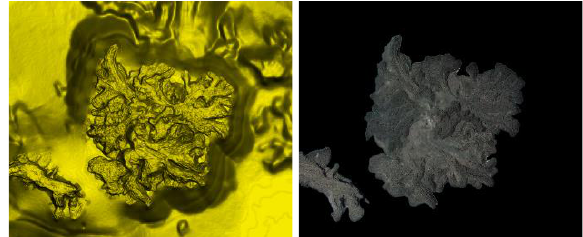
Figure 14. Left - Final 2.5 DEM of Santorini (Kammeni), Right - RGB Data from Sentinel-2 image on top of the